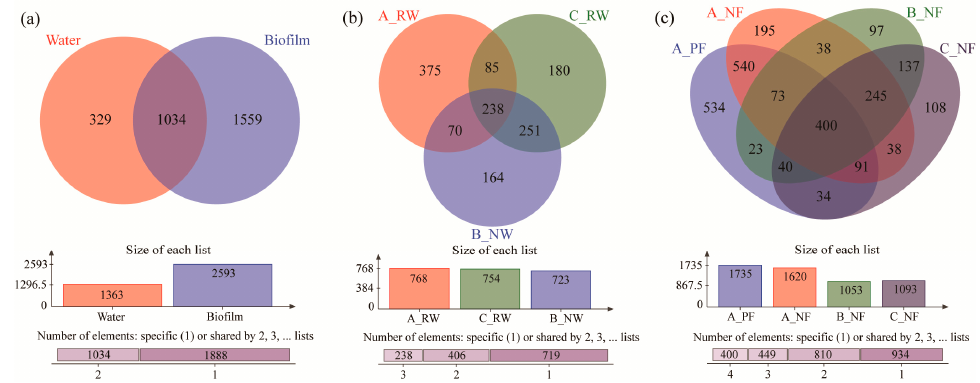
Figure 3. The microbial taxa of different groups at the OTU level. ( a ) The differences between water and biofilm; ( b ) water in different devices; ( c ) biofilms in different